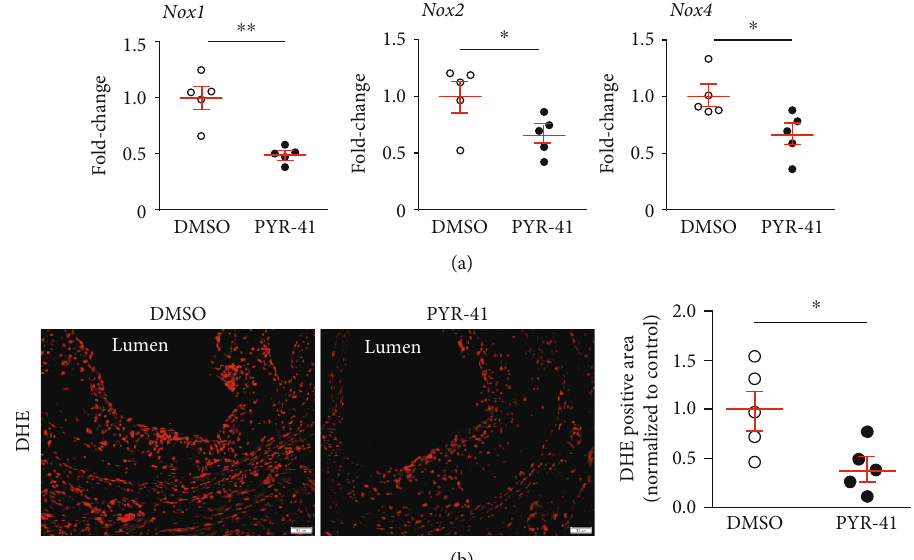
Figure 5: Inhibition of UBA1 decreased cellular oxidative stress in diet-induced atherosclerosis in Apoe-/- mice. (a) Quantitative real-time PCR analysis of aortic expression of NADPH oxidases ( Nox1 , Nox2 , and Nox4 ). (b) DHE staining and quantitation of the lesional oxidative stress level in the aortic root. n = 5 per group; ∗ : < 0.05.